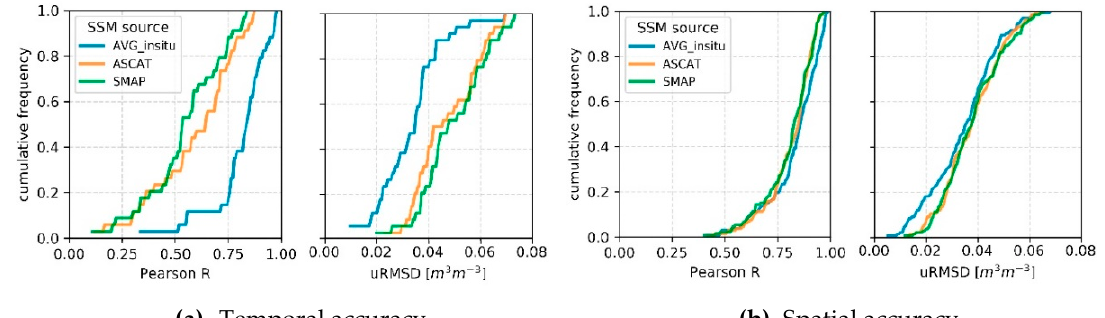
Figure 4. Cumulative frequency of Pearson R and uRMSD between measured and predicted soil moisture (model combination SSM+S+T+V). The statistical metrics were calculated for each sensor location, thus representing the ability of the model to capture temporal dynamics ( a ), and for each time-step, accounting for the model skill to reproduce spatial patterns ( b ).